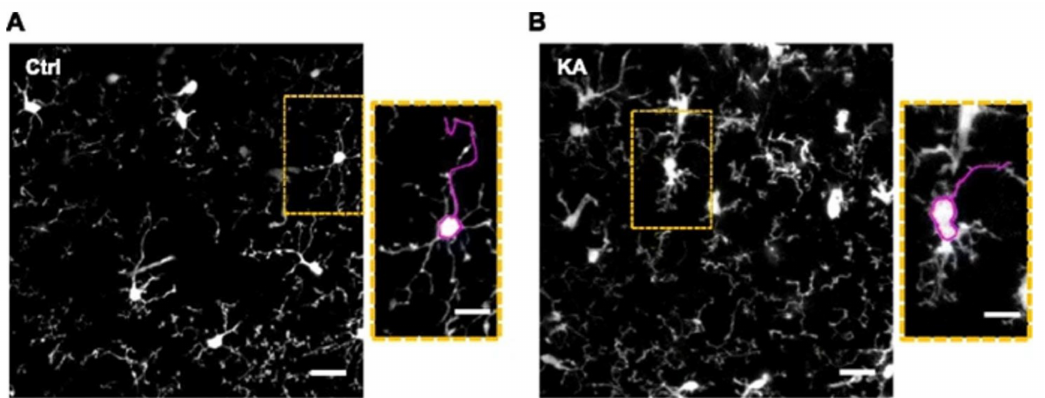
Figure 2. Two-photon images of microglial cells obtained in control mice ( A ) and KA-induced status epilepticus mice ( B ) depicting significantly different cell morphologies. Cell body outlines were drawn manually to determine cell sizes. After treatment with KA, microglial cells are significantly larger and have significantly shorter processes (consider the cell depicted in the inset images). Scale bars: 10 µ m (main images) and 6 µ m (inset images). Adapted from “Altered morphological dynamics of activated microglia after induction of status epilepticus” (Avignone et al., Journal of Neuroinflammation , 2015